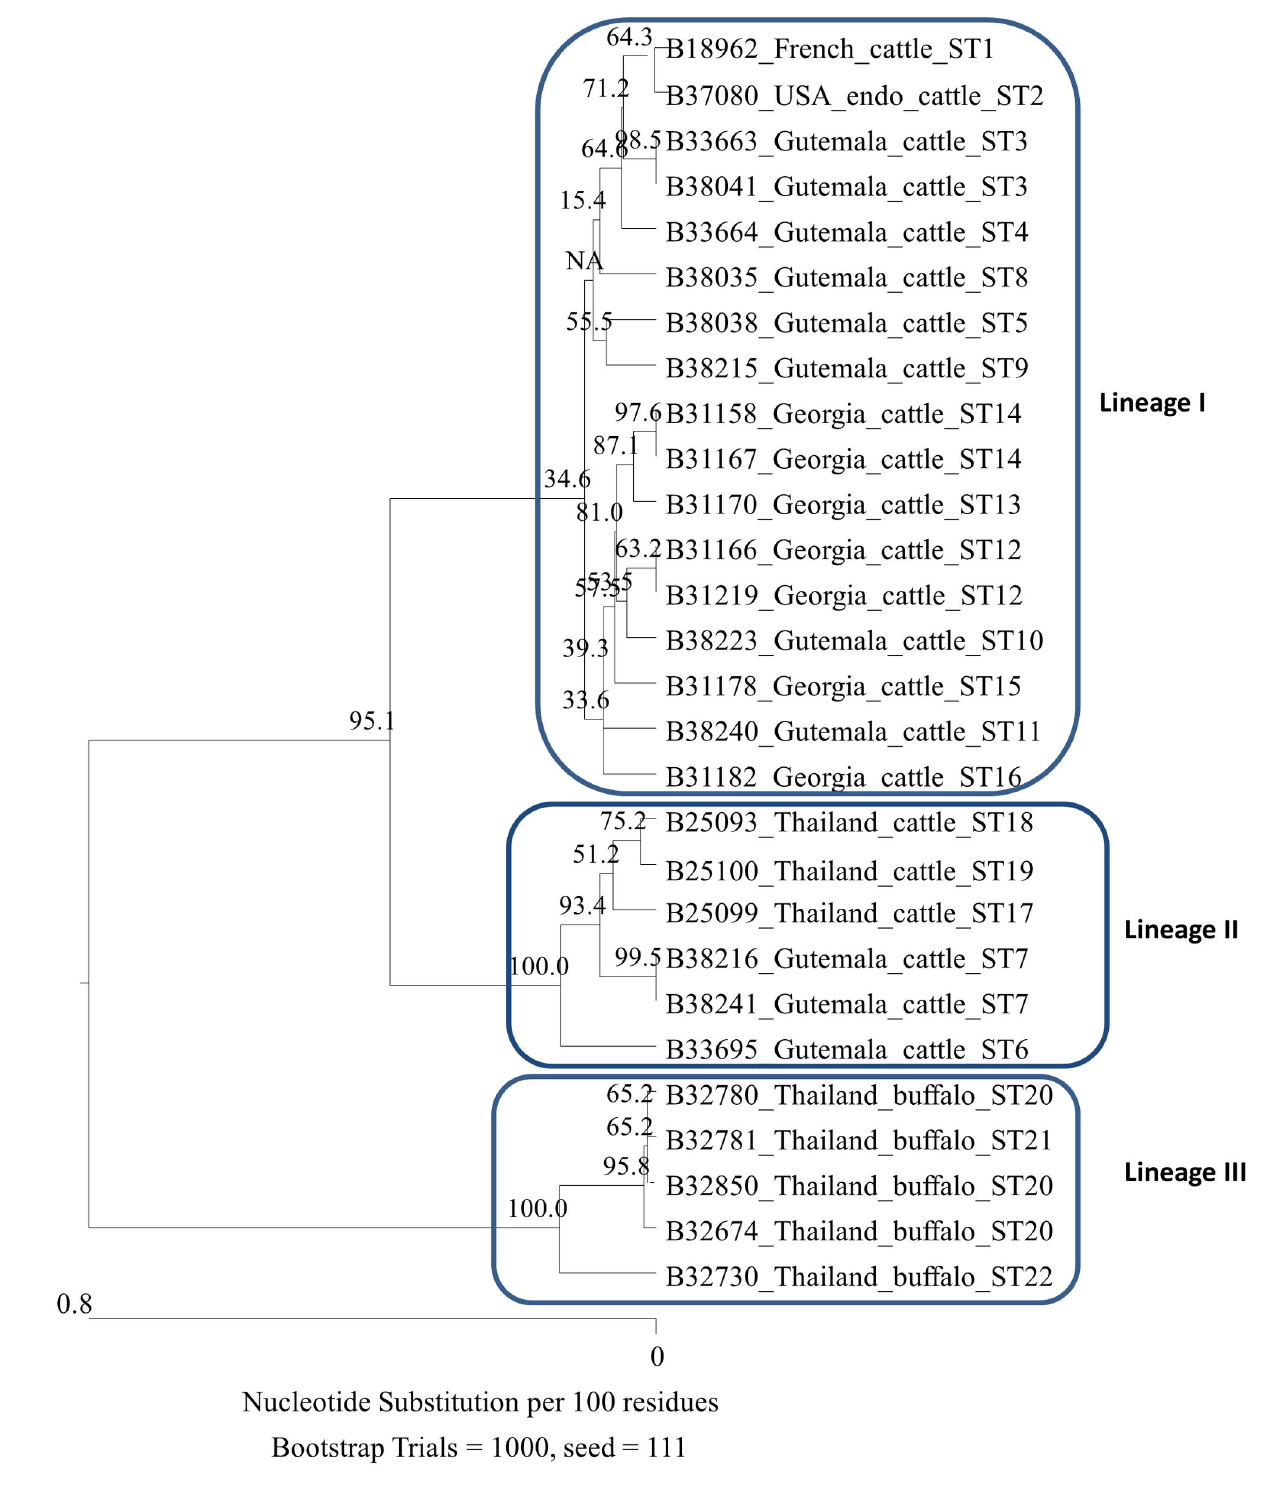
Figure 1. Phylogenetic relationships of the 28 B. bovis isolates inferred from 5085bp - 5119bp concatenated sequences of ftsZ , gltA , groEL, nuoG , ribC , rpoB , ssrA , and ITS fragments. Following each isolate are geographical origin, bovine host source, and sequence type (ST) classification. Phylogenetic tree was constructed by N-J method, and bootstrap values were calculated with 1,000 replicates. A total of 22 STs were identified, which fall into three lineages (square circled clades). doi: 10.1371/journal.pone.0080894.g001 PLOS ONE |